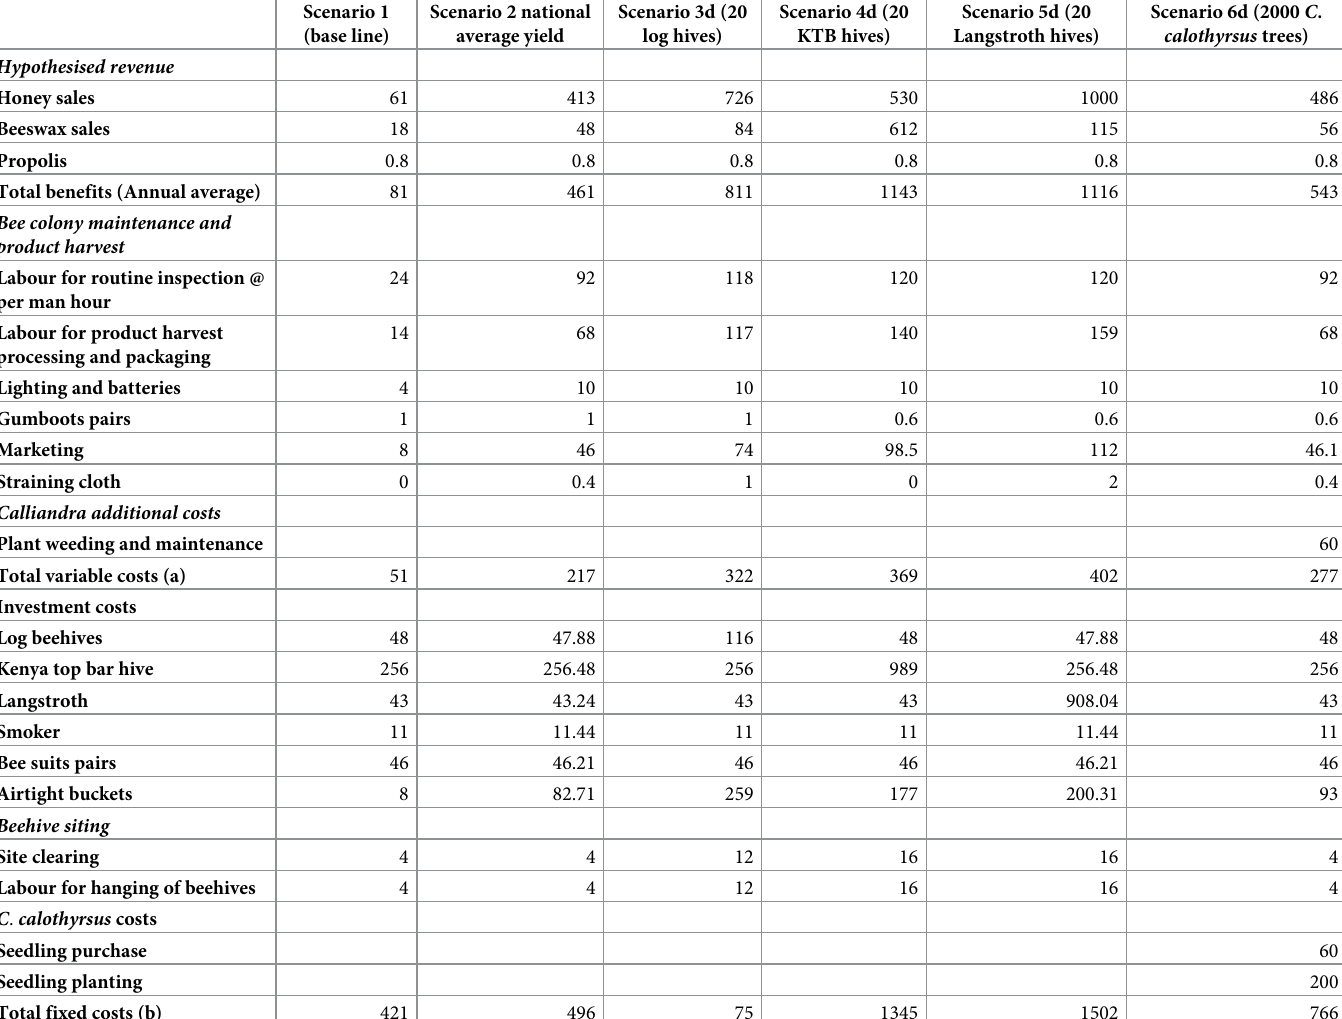
Table 1. Mean cost for modelled scenarios �